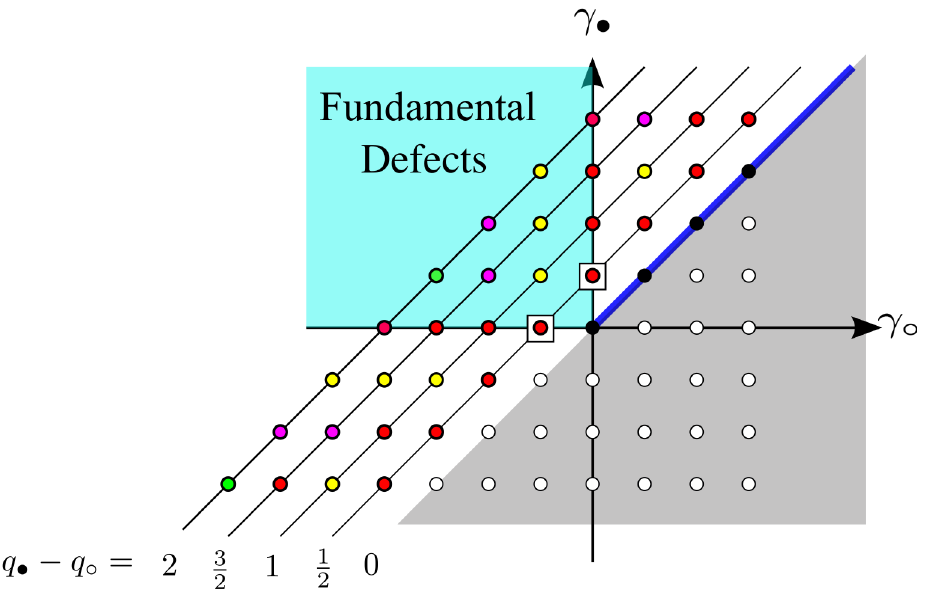
Figure 9 . Orbits of defects in the su 2 lattice. Lines of constant magnetic charge contain BPS lines which are part of the same orbit (indicated here using dots of the same colors along the same line). In blue we are drawing the Wilson